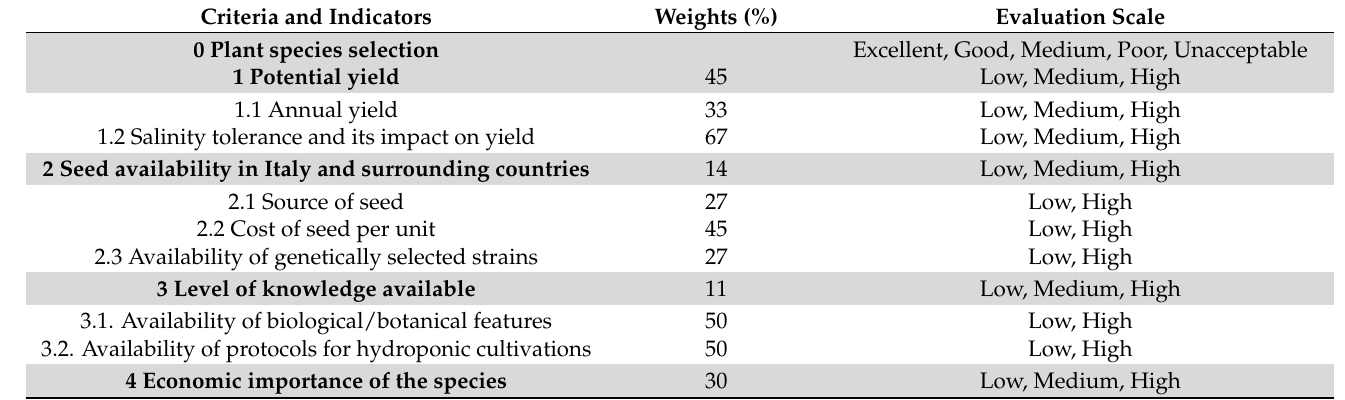
Table 2. Tree of attributes, assigned weights, and evaluation scale used in the present